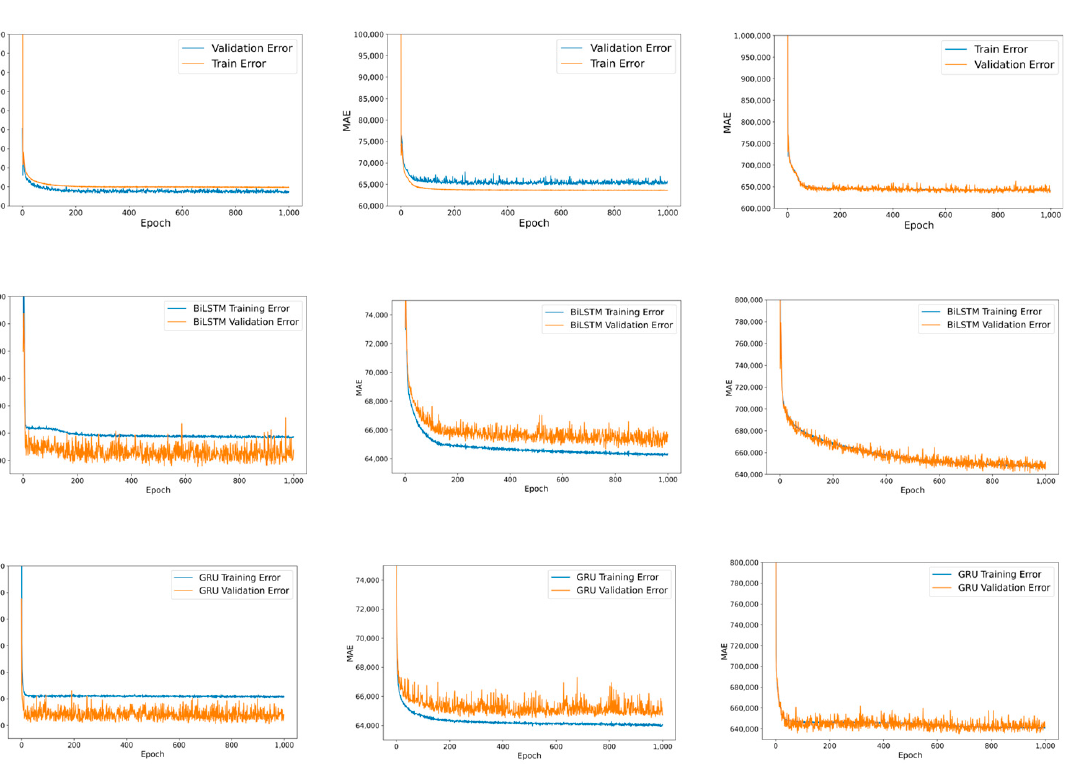
) values. (cid:3036) (cid:4594)